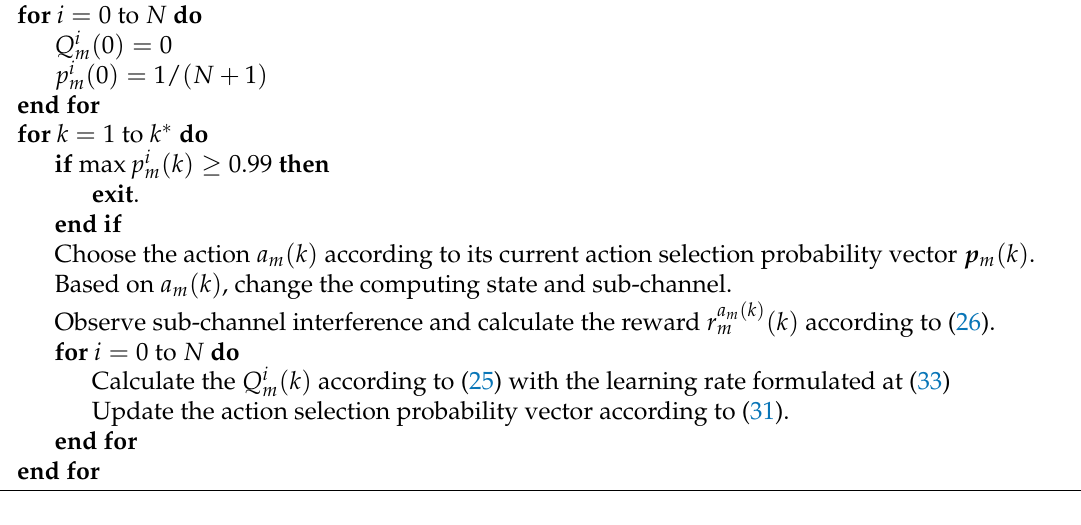
Algorithm 2 Distributed Q-learning for device m with Boltzmann learning